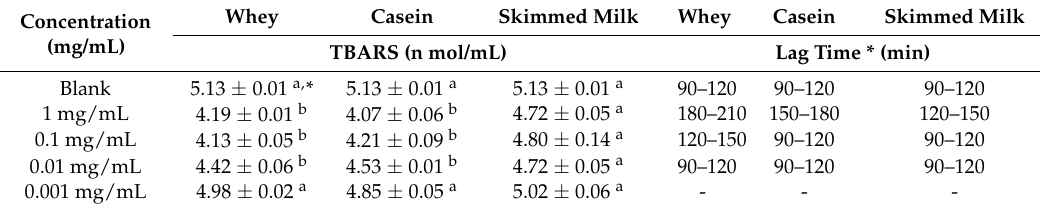
Table 3. Effects of bovine colostrums protein on the formation of Thiobarbituric Acid Reactive Substances (TBARS) and conjugated dienes on low density lipoprotein (LDL) oxidation induced by Cu 2+ .